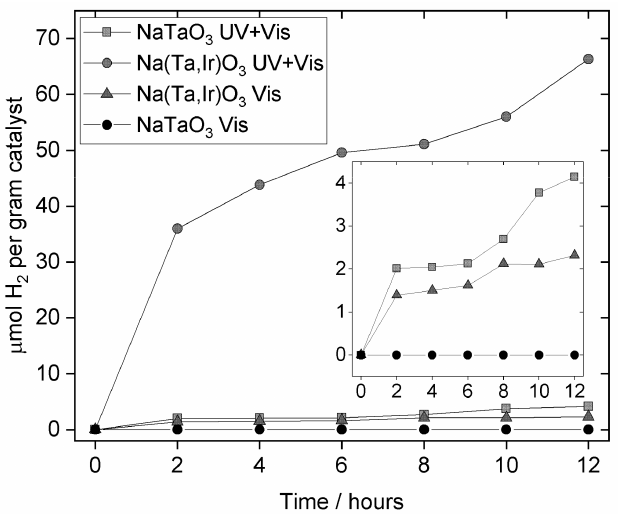
Figure 9. Photocatalytic hydrogen evolution observed from NaTaO 3 and Ir-substituted